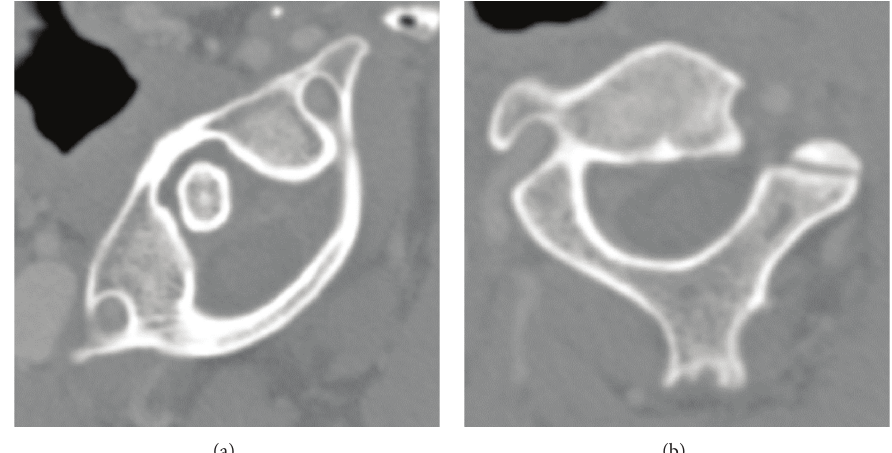
Figure 2: Computed tomography revealed that the atlas was rotated to the right centering on the dens of the axis. (a) Axial view of atlas and (b) axial view of axis.